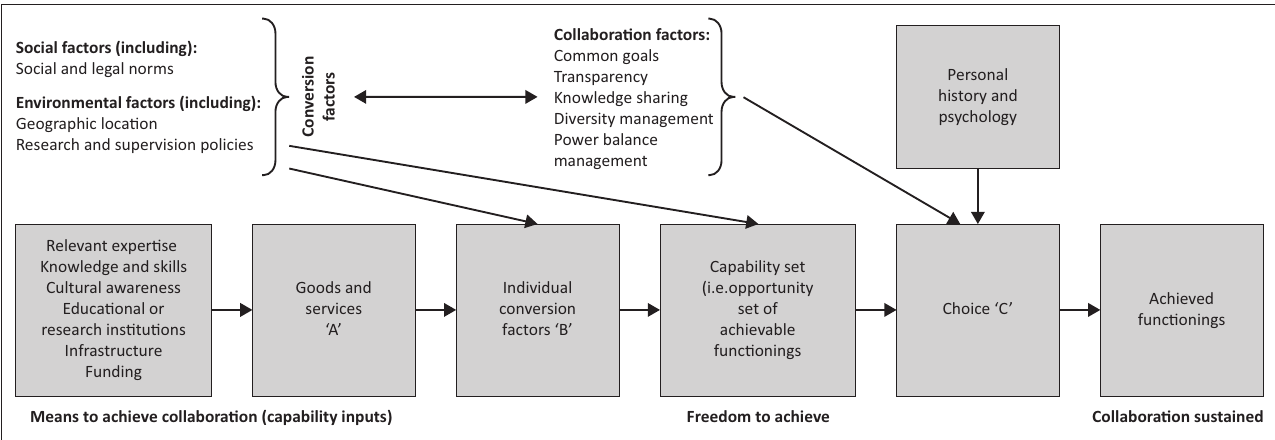
FIGURE 2: Main components and factors in the process of research collaboration, adapted according to the